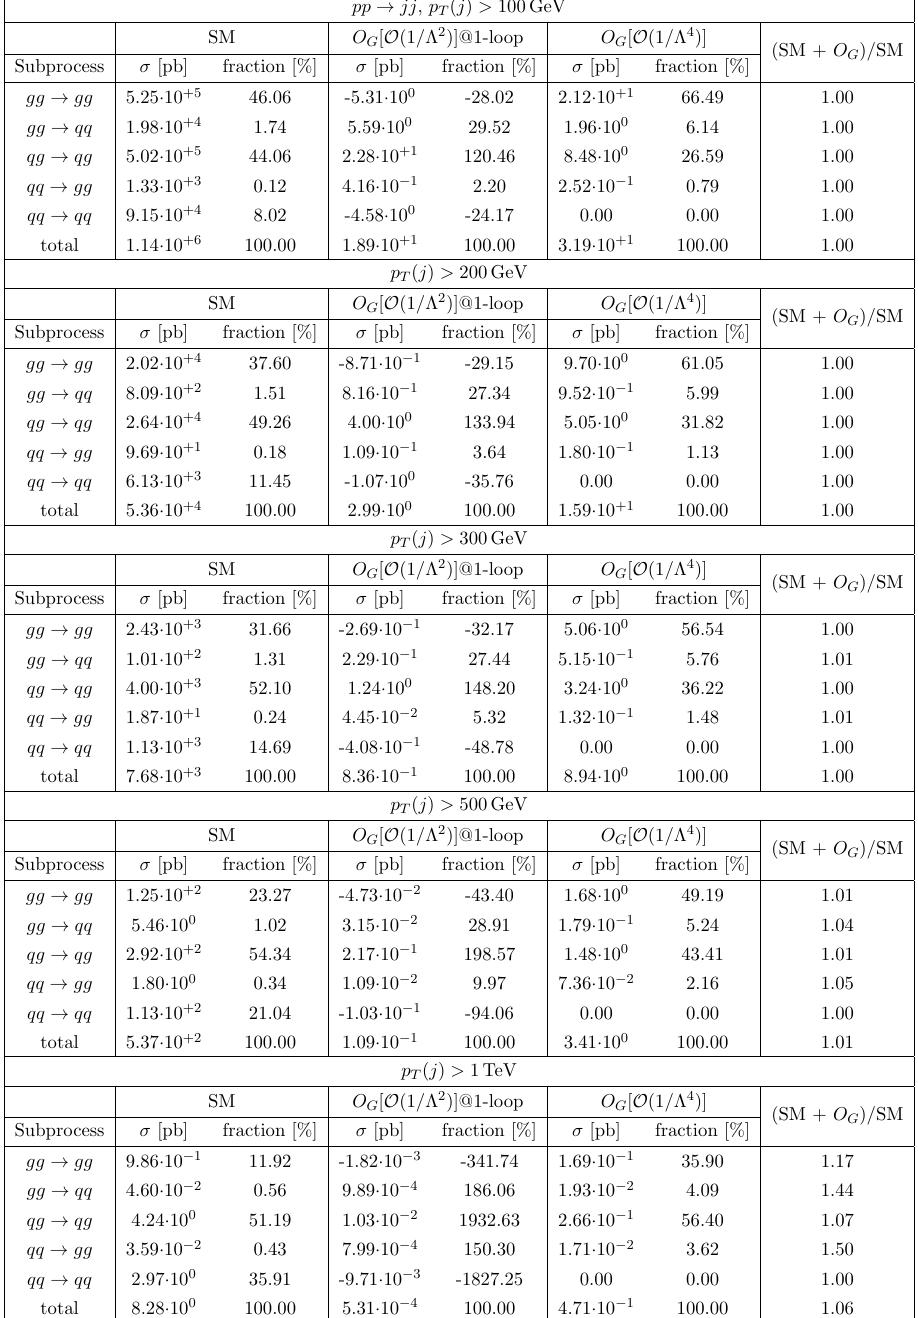
Table 6 . Contributions from the di(cid:11)erent partonic subprocesses of di-jet production at the LHC13 in the SM and with exactly one insertion of the O G operator in the amplitudes, leading to matrix element contributions of order O (1 = (cid:3) 4 ) at the tree level and O (1 = (cid:3) 2 ) at the one-loop level, shown separately here. We remind the reader that tree-level interference contributions with exactly one insertion of the O G operator are exactly